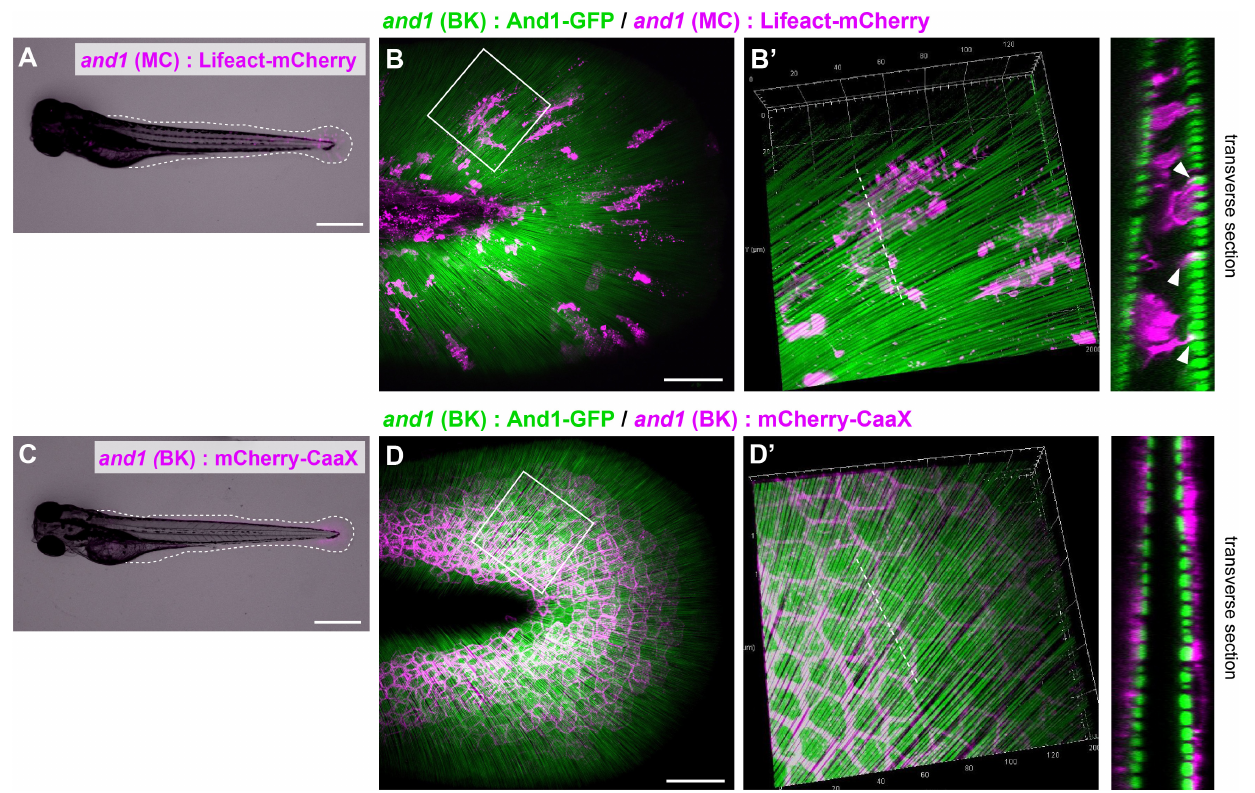
FIGURE 1 | Distribution pattern of the mesenchymal cells in larval fins. (A) Image of the whole body and (B) the median fin fold of the transgenic (TG) larva expressing Lifeact-mCherry under the 5 x and1 (MC) promoter. The white dot line shows the outline of median fin fold. (B) Localization pattern of mesenchymal cells (expressing Lifeact-mCherry: magenta) and actinotrichia (labeled by And1-GFP: green) in the larval fin. (B (cid:48) ) Magnified image of the white box in (B) . Transverse section image of the white dotted line is shown in the right panel. Actin-rich pseudopodia interact with actinotrichia (white arrowheads). (C) Image of the whole body and (D) the median fin fold of TG larva expressing mCherry-CaaX under the and1 (BK) promoter. The white dotted line shows the outline of the median fin fold. (D) Localization pattern of basal keratinocytes (expressing mCherry-CaaX: magenta) and actinotrichia (labeled by And1-GFP: green) in the larval fin. (D (cid:48) ) The magnified image of white box in (D) . Transverse section image at the white dotted line is shown in the right panel. All larvae were at the stage of 3 dpf. MC, mesenchymal cell specific promoter designated as 2P (cid:49) epi in the previous paper (Lalonde et al., 2016); BK, basal keratinocyte specific promoter designated as 1.4 k and1 pro in the previous paper (Kuroda et al., 2018). Scale bars: 500 µ m in (A,C) , 50 µ m in (B,D)